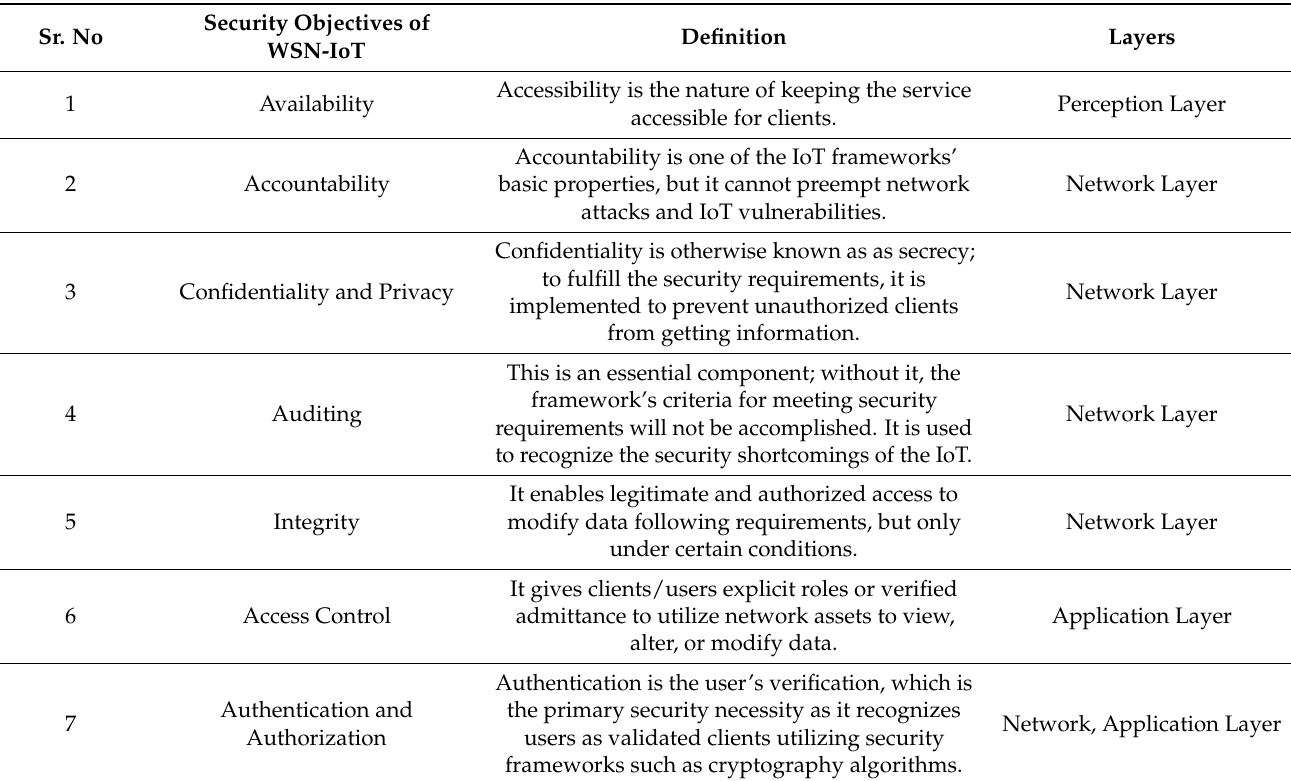
Table 2. Security objectives of